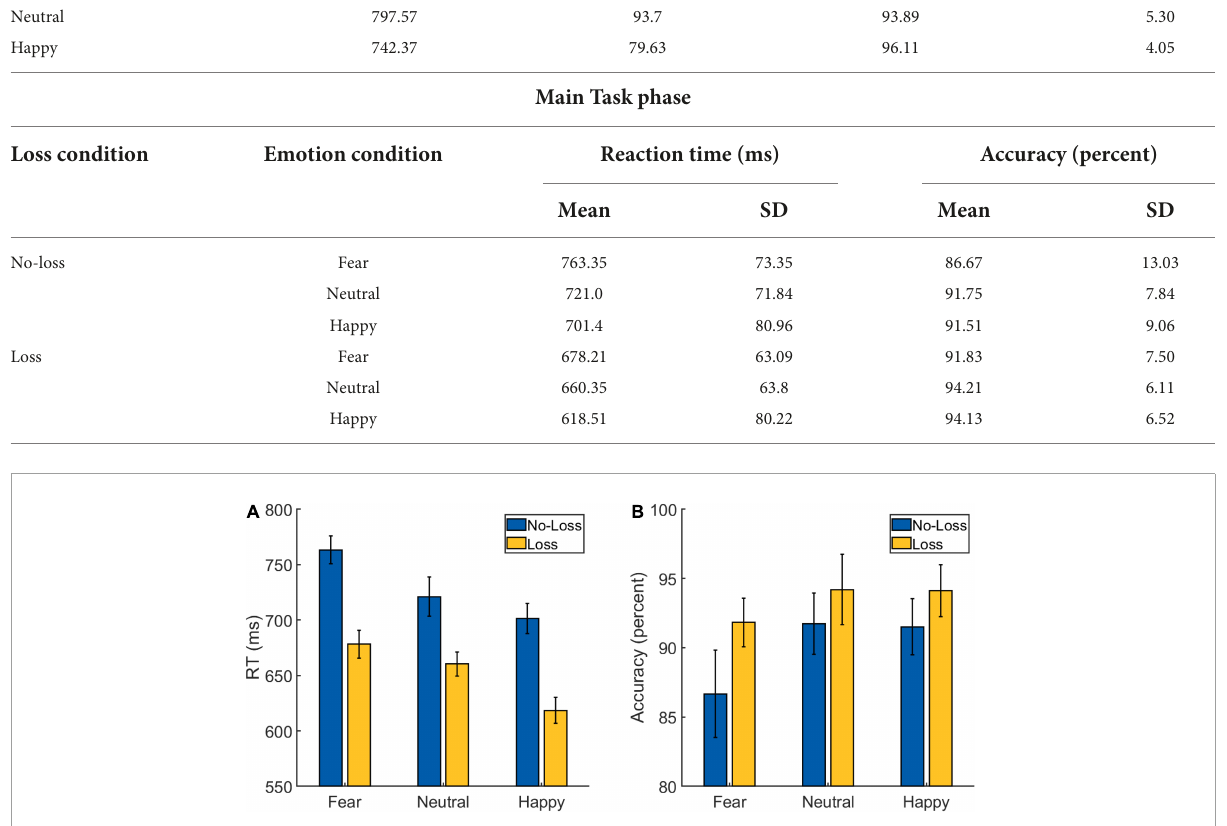
FIGURE3 Behavioral data from the Main Task Phase of Experiment 2: (A) reaction time (RT) and (B) accuracy scores. The error bars represent confidence intervals ( ± 1.96 × within-subject Standard Error) as discussed in O’Brien and Cousineau (2014).